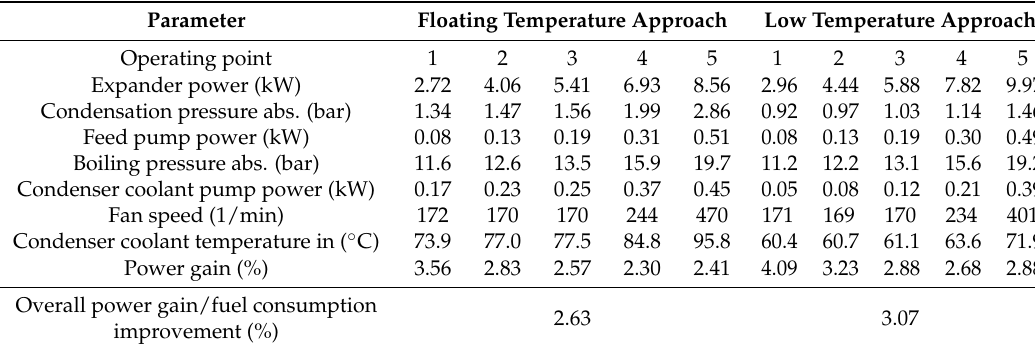
Table 3. Transient simulation results,